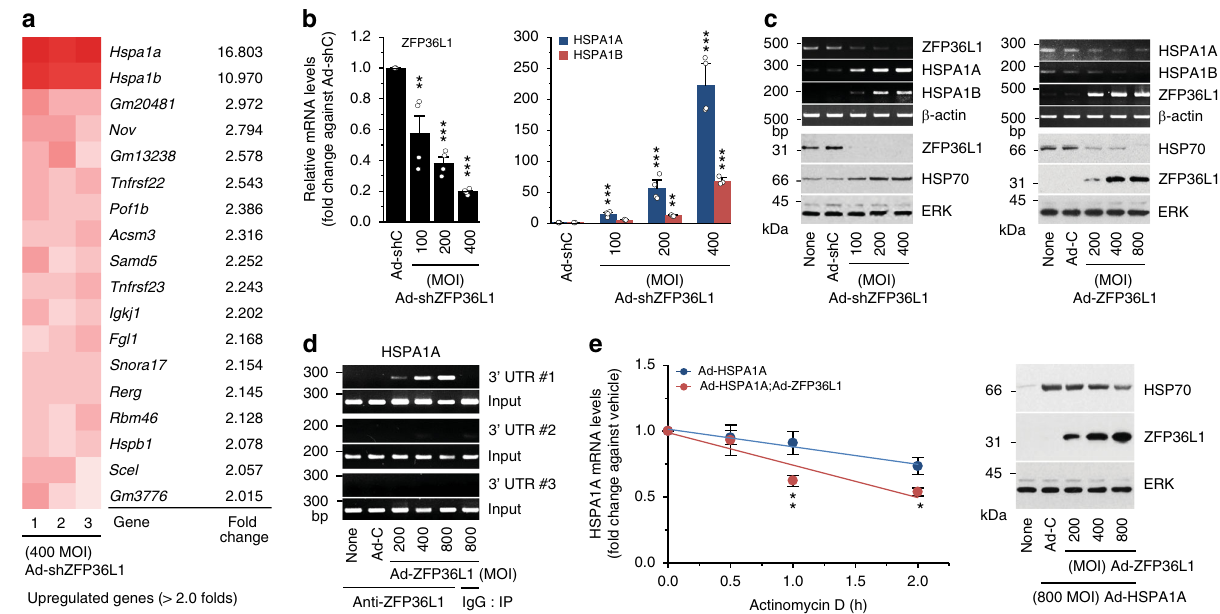
Fig. 4 ZFP36L1 targets HSP70 family members in chondrocytes. a Microarray analysis of chondrocytes infected with 400 MOI of Ad-shZFP36L1 to knock down ZFP36L1 (3 replicates). b , c qRT-PCR ( b ) and RT-PCR and western blot analyses ( c ) of ZFP36L1, HSPA1A, HSPA1B, and HSP70 in chondrocytes infected with Ad-C (800 MOI) or the indicated MOIs of Ad-shZFP36L1 or Ad-ZFP36L1 for 36 h ( n = 4). Representative images are presented ( c ). d RNA binding of ZFP36L1 in chondrocytes infected with Ad-C or Ad-ZFP36L1. The binding of ZFP36L1 to the 3 ′ -UTR of HSPA1A was determined by RT-PCR of immunoprecipitates obtained using anti-ZFP36L1 or IgG. Representative images are presented from fi ve biologically independent samples. e mRNA decay assay. Chondrocytes were infected with Ad-HSPA1A with or without Ad- ZFP36L1 for 12 h, and then exposed to Actinomycin D (1 μ g ml − 1 ) for the indicated time periods. The mRNA levels of HSPA1A were quanti fi ed by qRT-PCR analysis ( n = 9). Representative western blot images of HSP70 and ZFP36L1 proteins. Means ± s.e.m. with one-way ANOVA (* P < 0.01, ** P < 0.001, and *** P <